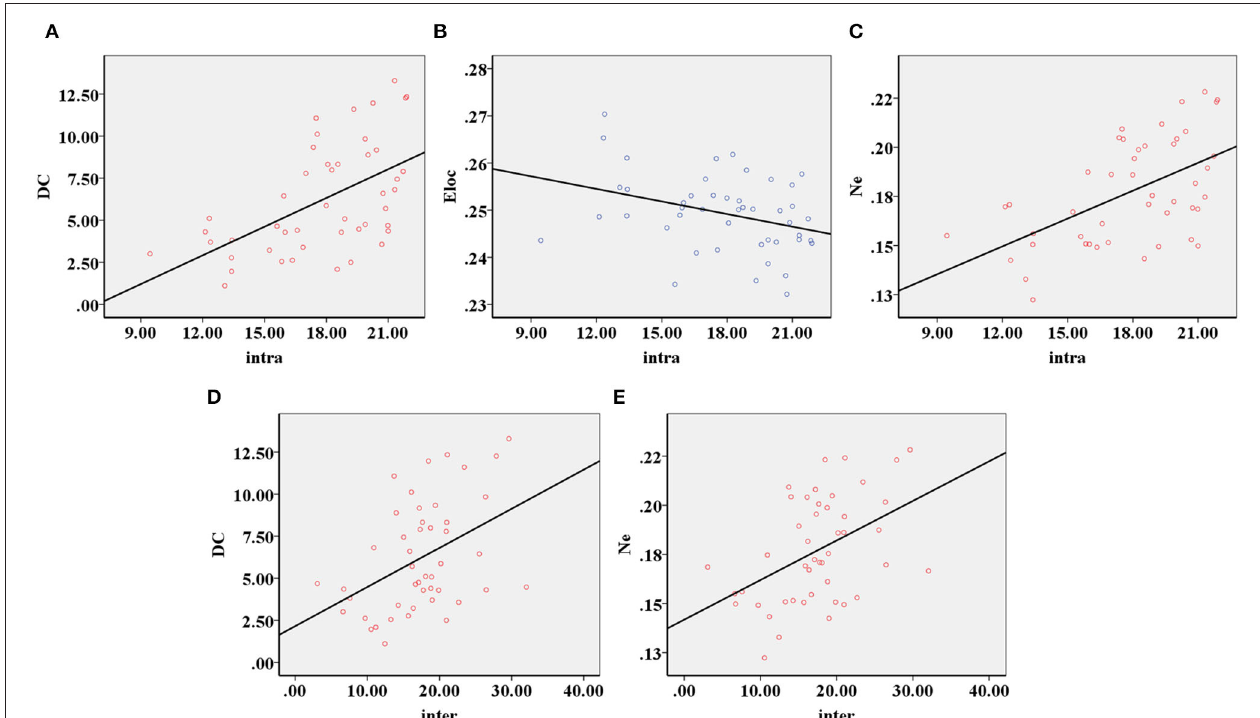
FIGURE 5 | The correlation analysis of modular analysis with nodal and global parameters. (A) The decreased intra-modular interaction of the occipital lobe module in the patient group was positively correlated with the Dc ( p < 0.001). (B) The decreased intra-modular interaction of occipital lobe module in the patient group was negatively correlated with the E loc ( p = 0.020). (C) The decreased intra-modular interaction of occipital lobe module in the patient group was positively correlated with the Ne ( p < 0.001). (D) The decreased inter-modular interaction of parietal occipital lobe module in the patient group was positively correlated with the Dc ( p = 0.003). (E) The decreased inter-modular interaction of parietal occipital lobe module in the patient group was positively correlated with the Ne ( p = 0.001).